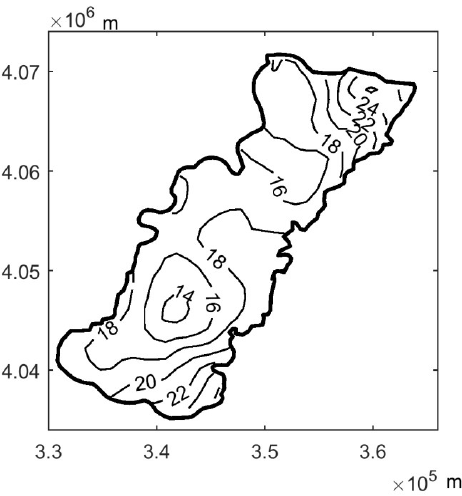
Figure 8. Groundwater contour map of the steady state (in m a.s.l.).